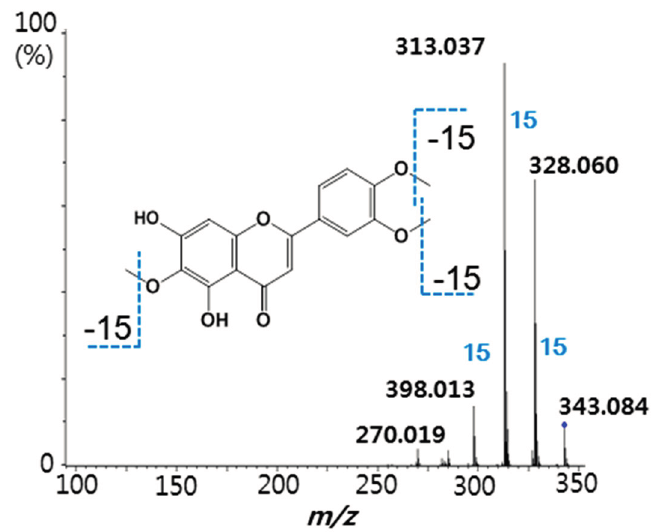
Figure 3. Negative ion electrospray tandem mass spectra of the deprotonated molecule of eupatilin at m / z 343. Product ion mass spectra were obtained using collision-induced dissociation at 18 eV